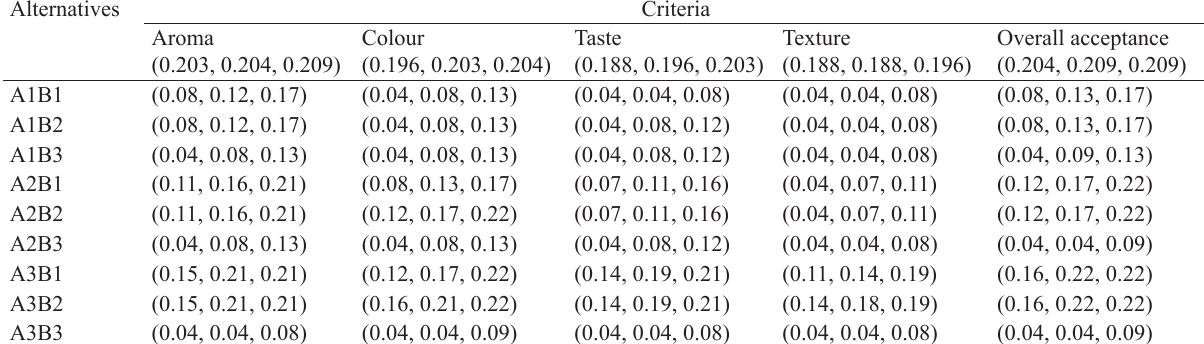
Table 11 Matrix of multiplication of criteria weights and alternative normalisation values